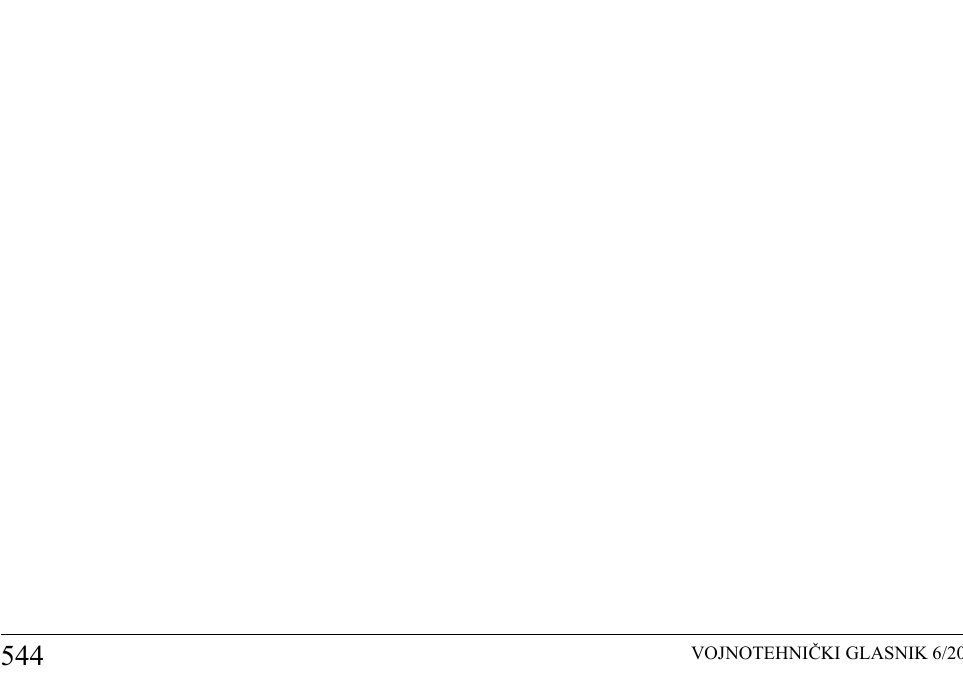
VOJNOTEHNI^KI GLASNIK